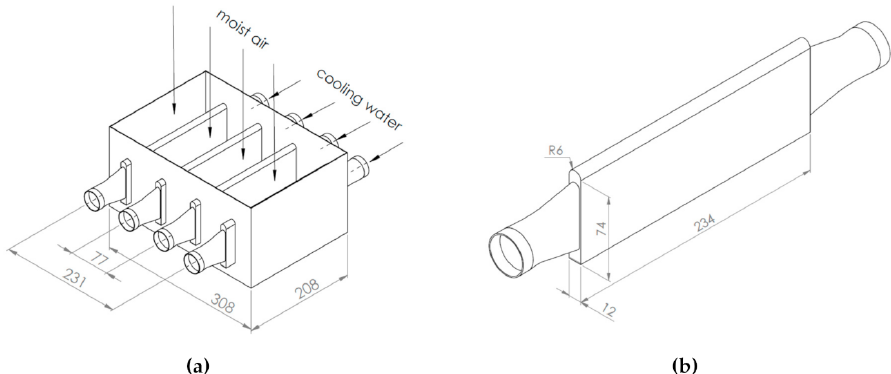
Figure 4. Section of test chamber with three vertical copper plates. ( a ) test chamber with four vertical flat plates; ( b ) single vertical flat